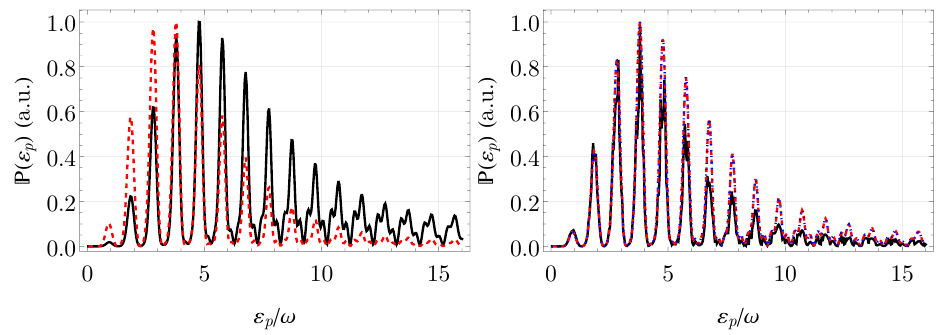
Figure 5. Photoelectron energy spectra, emitted along the x -axis within the polarization plane, for a neutral krypton target and a right-circularly polarized laser pulse. The left panel shows the spectra as computed with a hydrogenic 1 s initial wave function with adopted ionization potential and for a plane-wave Volkov continuum (black-solid curve) as well as a Coulomb–Volkov continuum (red-dashed curve). On the right panel, in contrast, the spectra are computed for an initial 4 p orbital of neutral krypton and a plane-wave Volkov continuum (black-solid curve), a Coulomb–Volkov continuum (red-dashed curve) as well as a distorted-Volkov continuum (blue-dotted curve). In all these computations, a right-circularly polarized sin 2 pulse of wavelength λ = 800 nm, intensity I = 10 14 W/cm 2 , carrier–envelope phase φ ( CEP ) = 0 and with n p = 8 cycles has been